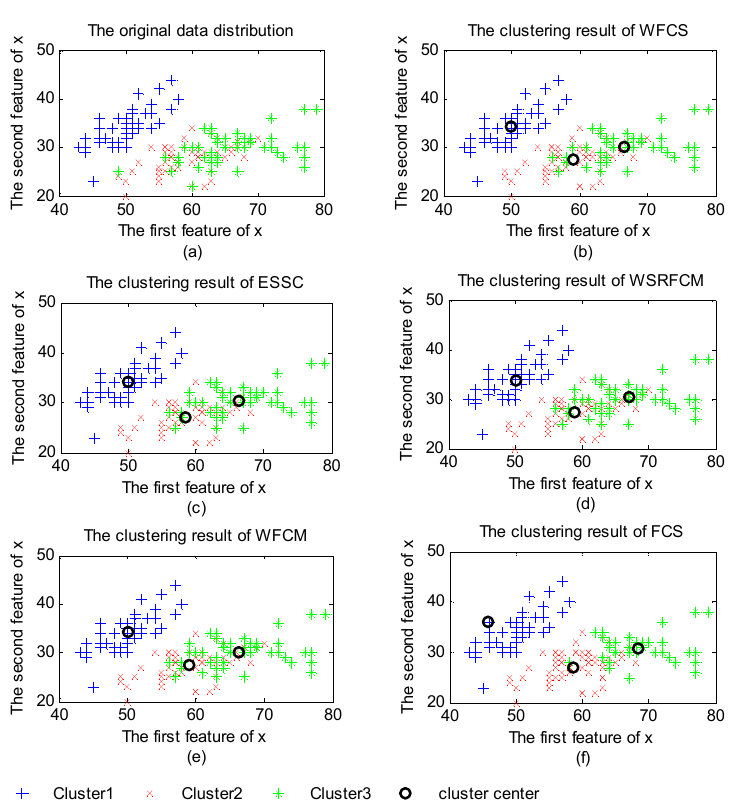
Figure 2. ( a ) The original data distribution; ( b ) The clustering results of weighting fuzzy compactness and separation algorithm (WFCS); ( c ) The clustering results of enhanced soft subspace clustering algorithm (ESSC); ( d ) The clustering results of the feature weighting fuzzy clustering algorithm integrating rough sets and shadowed sets (WSRFCM); ( e ) The clustering results of the feature weighting fuzzy c-means algorithm (WFCM); ( f ) The clustering results of the fuzzy compactness and separation algorithm (FCS).